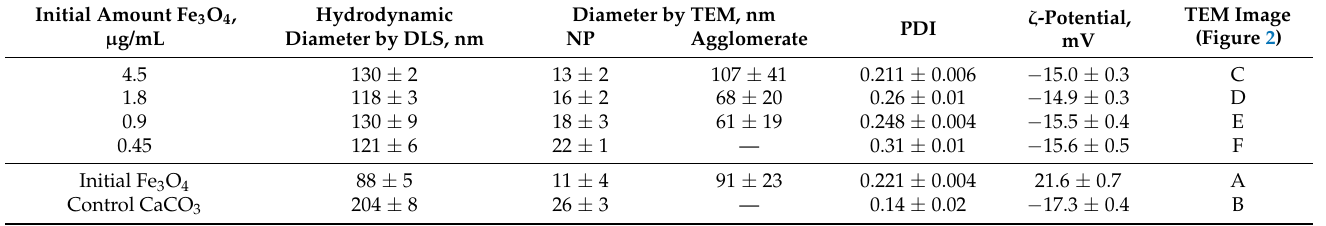
Table 1. Diameter by DLS and TEM, PDI, and ζ -potential of Fe 3 O 4 and CaCO 3 nanoparticles and 4.5 mg/mL for synthesis.